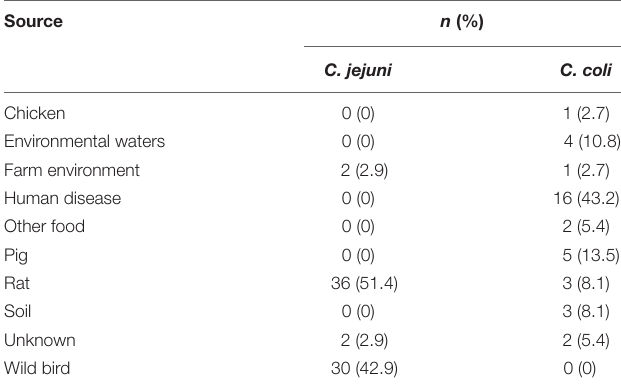
TABLE 1 | Sources of ED-positive isolates from the Campylobacter jejuni / coli PubMLST database.